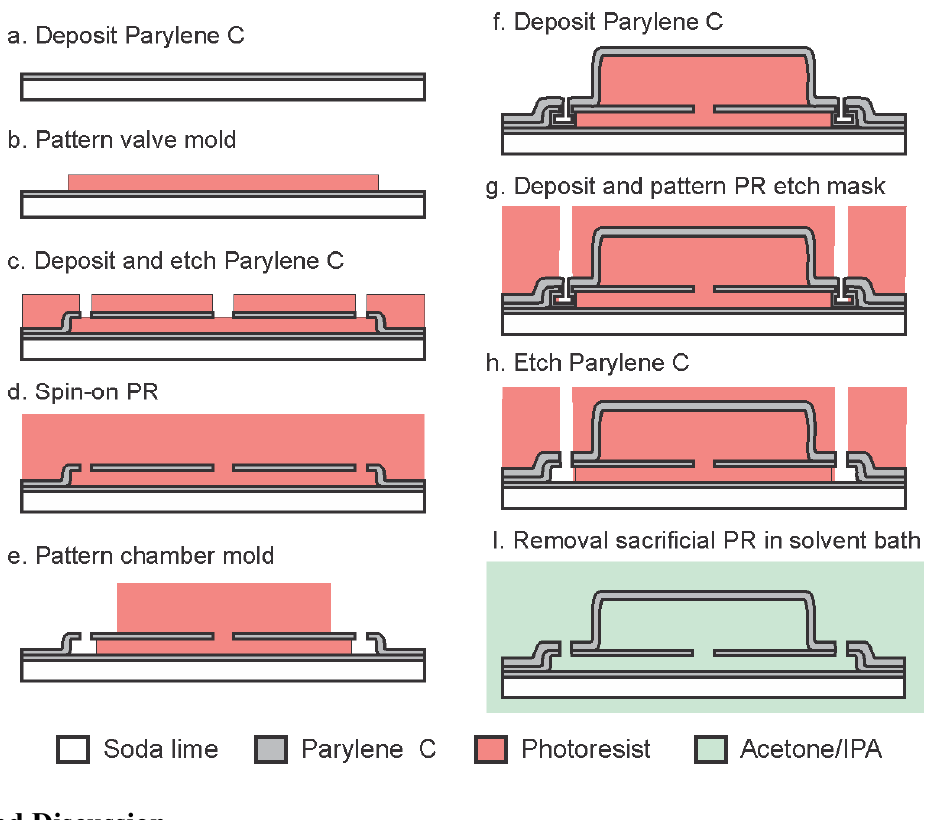
Figure 4. Low temperature (90 °C) multi-layer Parylene-C fabrication